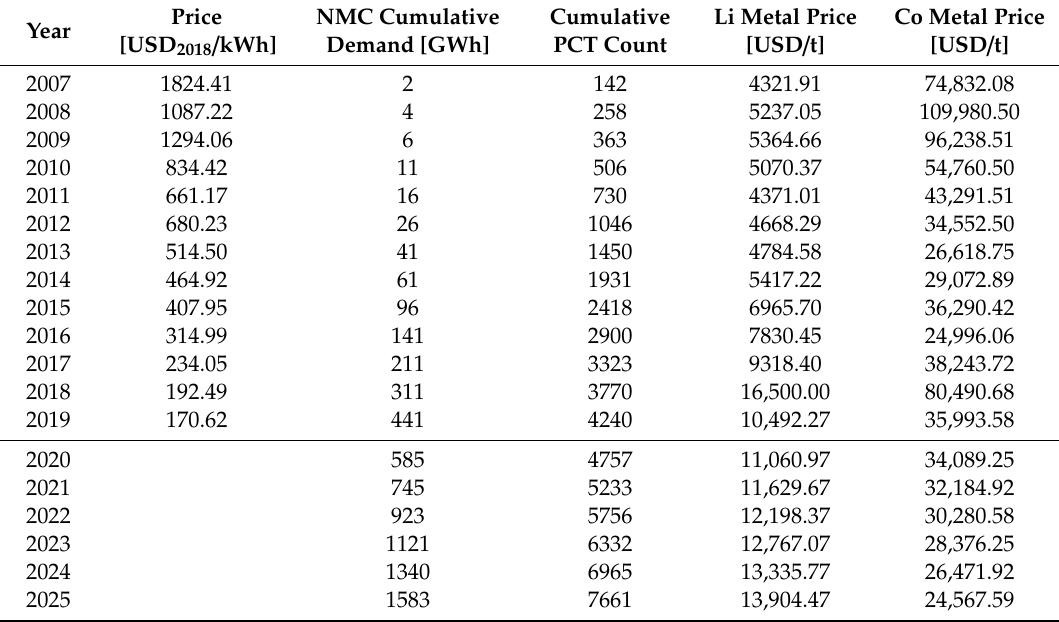
Table A1. Historical and forecasted values of the di ff erent factors in the learning curve models.